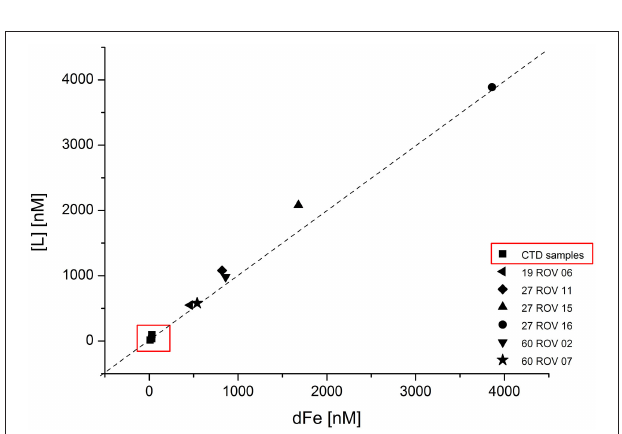
FIGURE 6 | Fe binding ligand ([L]) concentrations plotted against total dissolved Fe (dFe) for all ROV samples collected within the buoyant hydrothermal plume, and CTD samples collected within the non-buoyant plume. Dashed line represents the 1:1